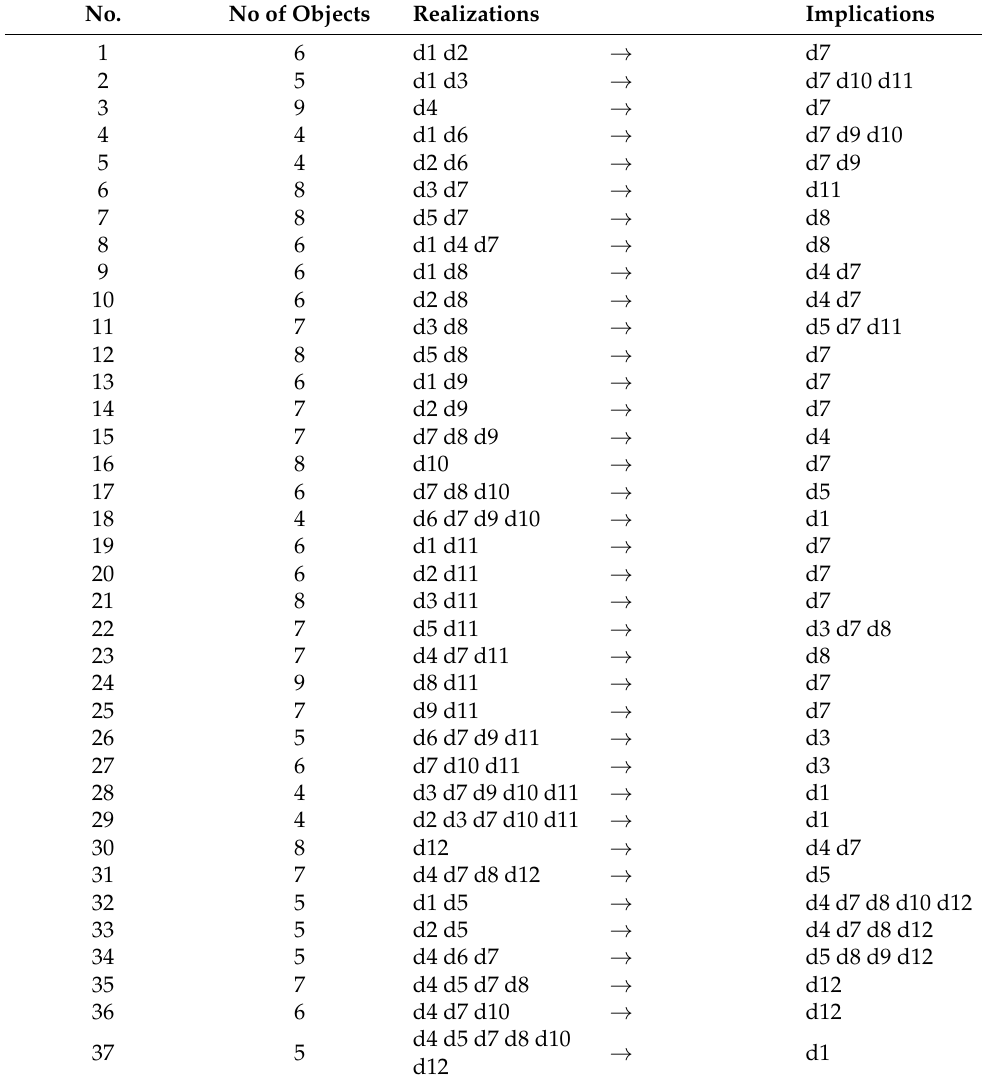
Table 8. List of implications for the binary data, obtained by application of Equation (7). No. No of Objects Realizations